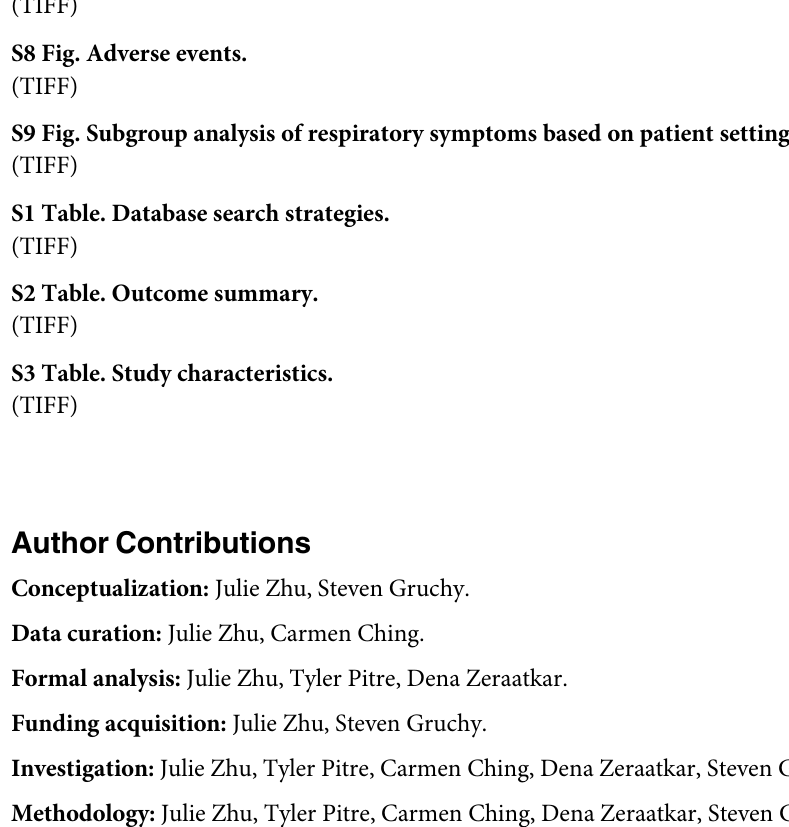
S1 Fig. Subgroup analysis of clinical escalation based on patient setting. (TIFF) S2 Fig. Subgroup analysis of composite end point based on patient setting. (TIFF) S3 Fig. Subgroup analysis of CRP level (mg/L) based on patient setting. (TIFF) S4 Fig. Subgroup analysis of gastrointestinal symptoms based on patient setting. (TIFF) S5 Fig. Subgroup analysis of mortality based on patient setting. (TIFF) S6 Fig. Subgroup analysis of adverse events based on patient setting. (TIFF) S7 Fig. C-reactive protein levels (mg/L). (TIFF) S8 Fig. Adverse events. (TIFF) S9 Fig. Subgroup analysis of respiratory symptoms based on patient setting. (TIFF) S1 Table. Database search strategies. (TIFF) S2 Table. Outcome summary. (TIFF) S3 Table. Study characteristics.